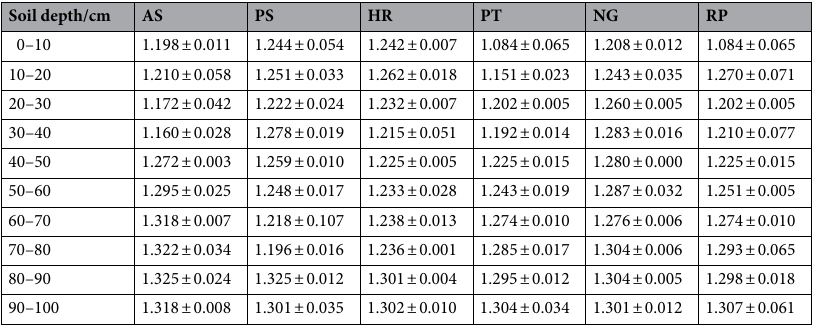
Table 2. Average bulk density at the 0–100 cm depth (mean ±